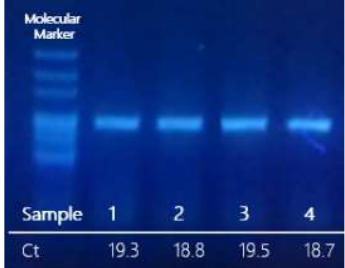
Figure 2. Agarose gel of the preparative RT-epPCR products from SARS-CoV-2-positive RNA clinical samples. The Ct obtained by qPCR (GPS™ SARS-CoV-2 dtec-RT-qPCR) assay has been indicated below each lane.